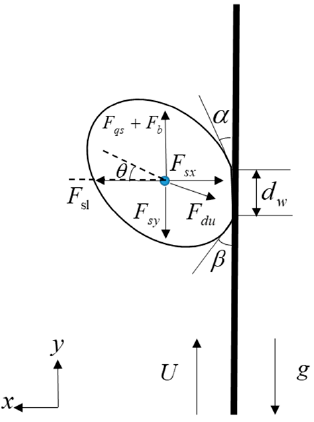
Figure 1. The analysis of forces in vertical surface.